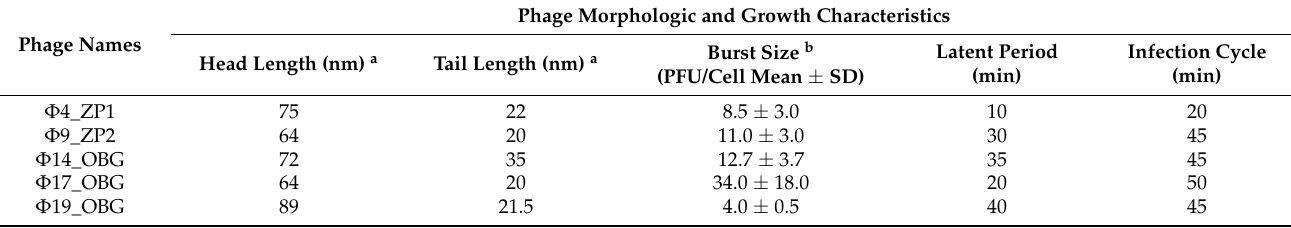
Table 1. Phage morphology at transmission electron microscopy and scanning transmission electron microscopy image analyses and growth characterization for the five newly isolated environmental lytic phages selected.